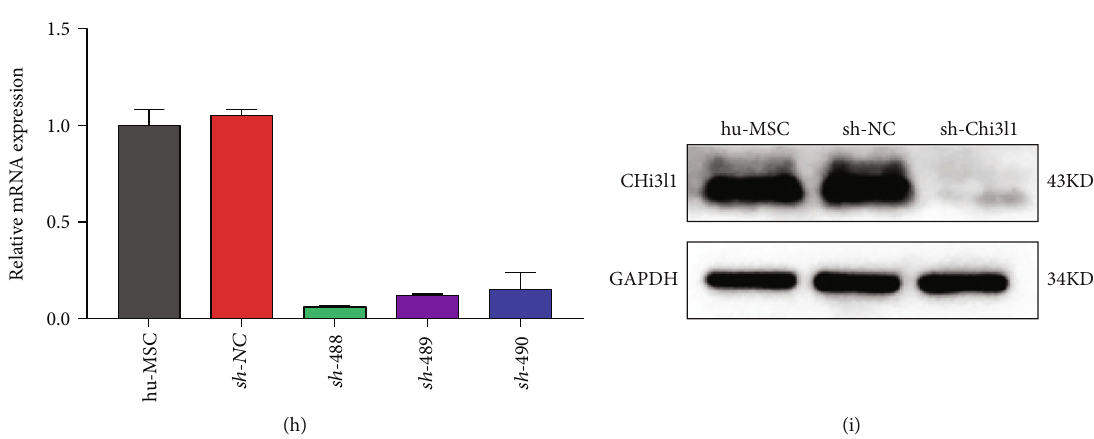
Figure 2: Chi3l1 knockdown in hUC-MSCs by Chi3l1-targeting shRNA lentiviral transfection. (a, b) The morphology of Chi3l1 knockdown hUC-MSCs (sh-Chi3l1-MSCs) shown by fl uorescence microscopy. Scale bar: 400 μ m. (c, d) Oil red O staining was used to analyze the adipogenic ability of sh-Chi3l1-MSCs. (c) Shows the control group, and (d) shows the induced group. (e, f) Alizarin red staining was used to analyze the osteogenesis ability of sh-Chi3l1-MSCs. (e) Is the control group, and (f) is the induced group. Scale bar: 200 μ m. (g) Immunophenotypic analysis of sh-Chi3l1-MSCs was performed by fl ow cytometry. (h) mRNA expression levels of Chi3l1 in sh-Chi3l1- MSCs analyzed by qPCR. (i) Western blotting was used to assess Chi3l1 protein expression in sh-Chi3l1-MSCs. sh-NC: sh-NC-MSCs; sh-Chi3l1: